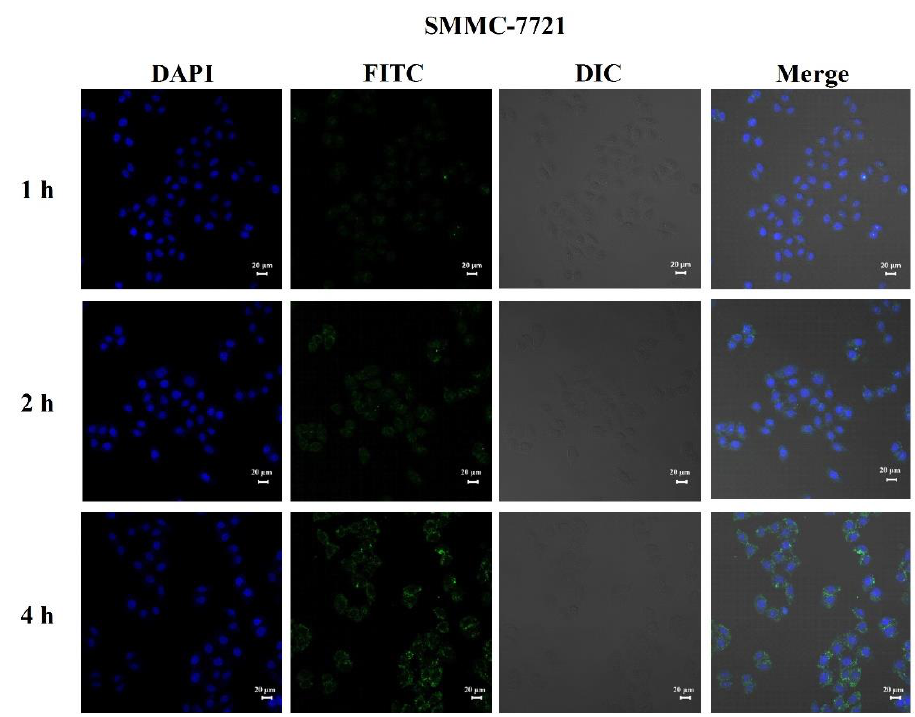
Figure 4. CLSM images of HepG2 and SMMC-7721 cells after incubation with FITC-TP 5 -NPs for 1, 2 1, 2 and 4 h. Abbreviations: CLSM, confocal laser scanning microscopy; DAPI, 4 (cid:48) ,6-diamidino-2- and 4 h. Abbreviations: CLSM, confocal laser scanning microscopy; DAPI, 4′,6-diamidino-2- phenylindole; FITC, Fluorescein isothiocyanate. phenylindole; FITC, Fluorescein isothiocyanate.